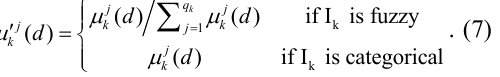
Table 3: Database ( D ′′ ) with Fuzzy